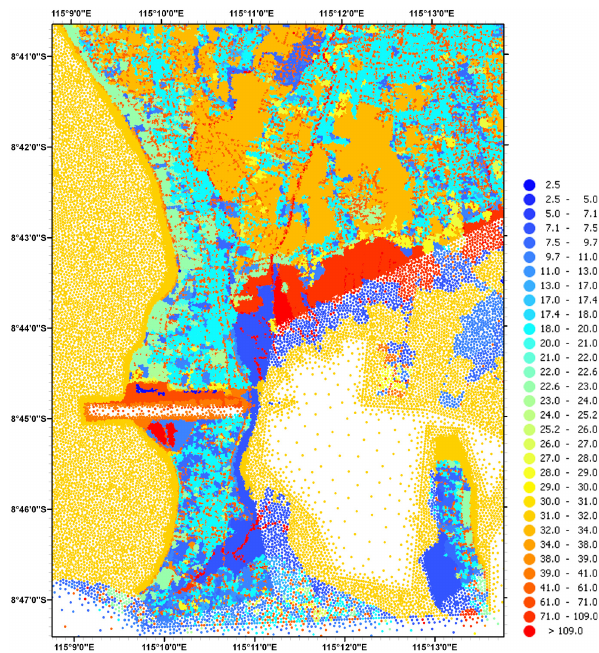
Figure 6: Sea surface height (seaside) and total water depth (upon land) for a scenario of earthquake magnitude 9 (045_10_mw9.0). Left: with detailed roughness map, right: with constant Manning value M = 32 m 1/3 /s everywhere.